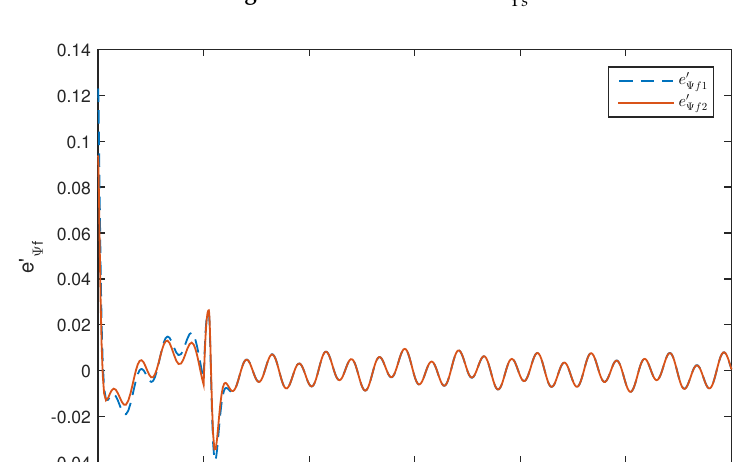
Figure 19. Estimation error e (cid:48) Ψ